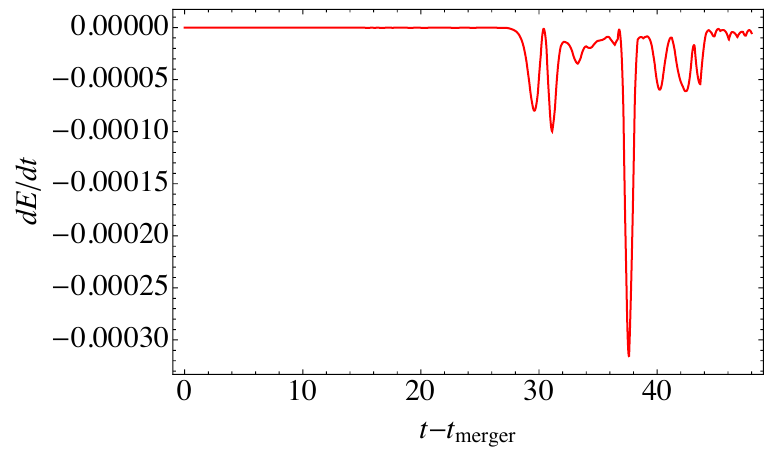
Figure 8 . Energy loss for our 7 D simulation as computed at a radius R = 30 from the merger point. The large peak at t − t 37 . 5 is produced when the dumbbell-shaped BH stops rotating merger ∼ and starts